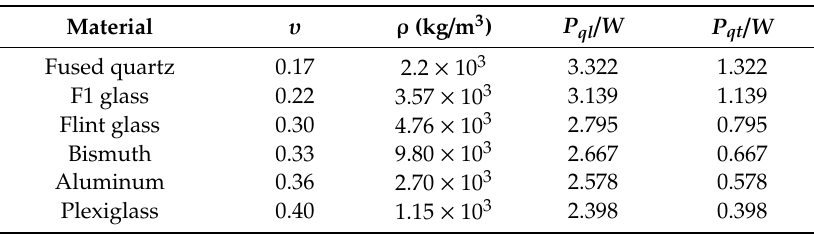
Table 1. The calculation results.